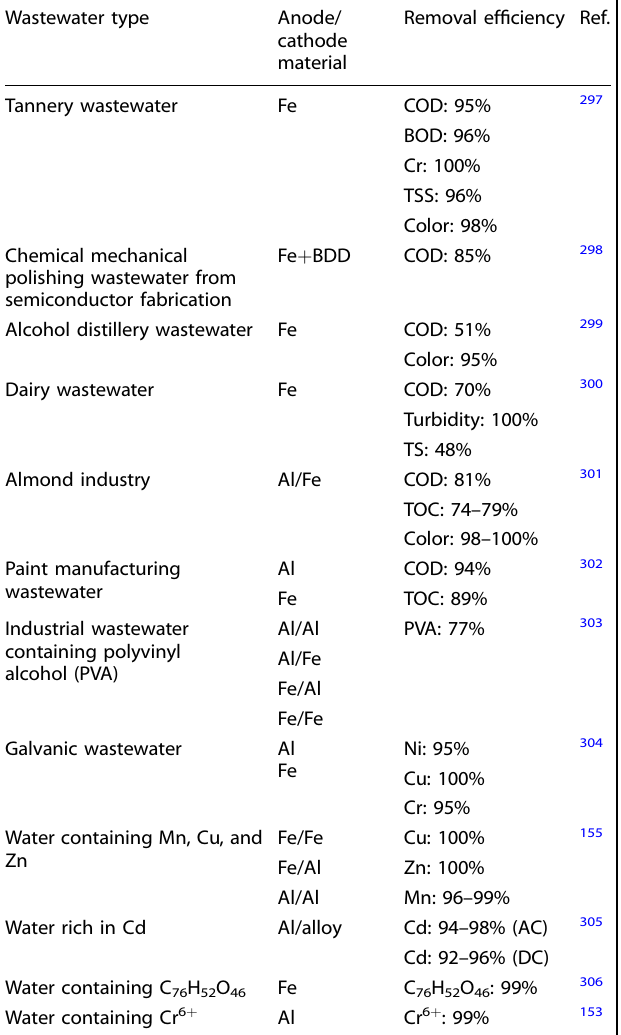
Table 6. Data obtained from literature on EC to treat industrial wastewater and water containing heavy